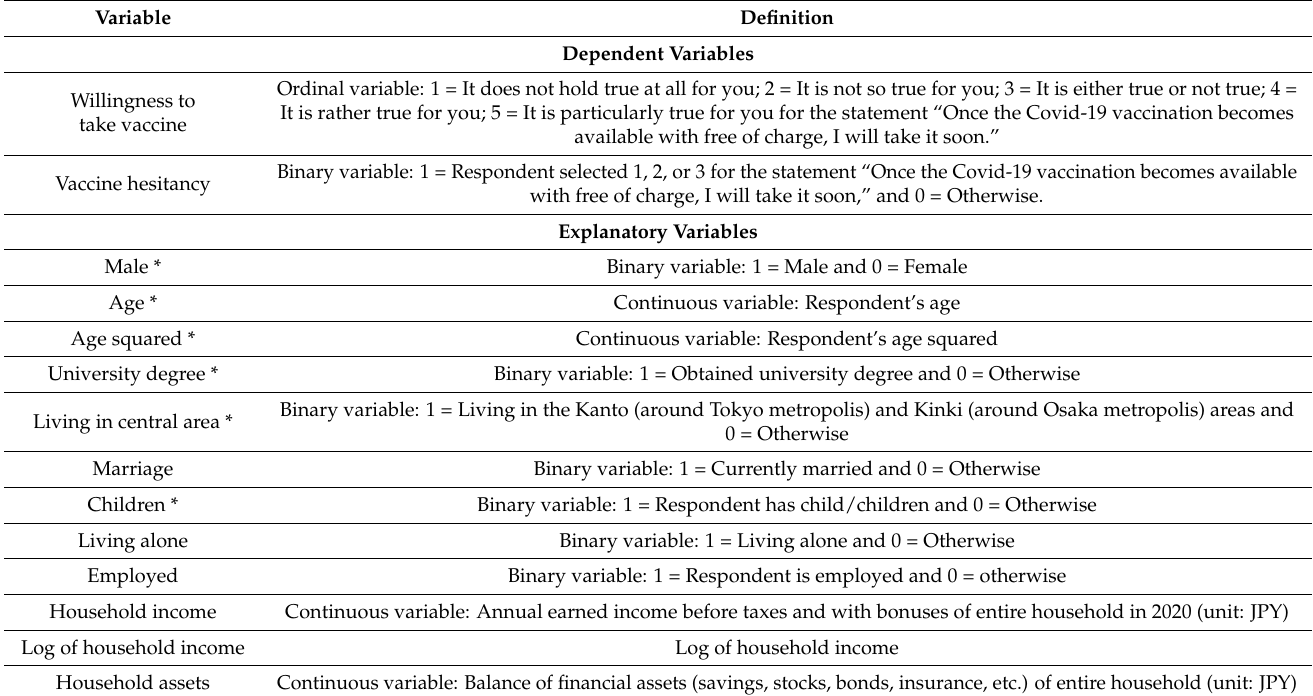
Table 1. Variable